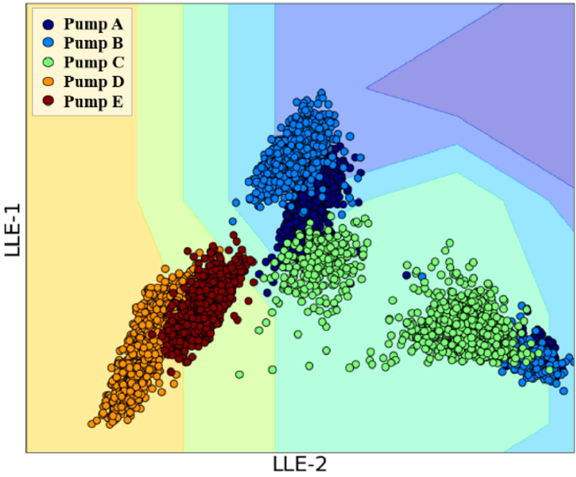
Figure 8. Fault isolation by DNN using LLE ( NN = 100).